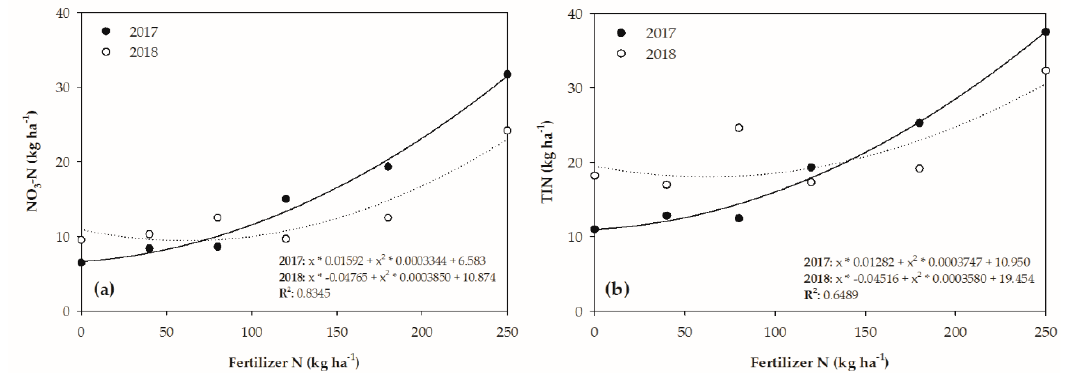
Figure 2. ( a ) response of post-harvest soil NO 3 -N and ( b ) total inorganic nitrogen (NO 3 -N + NH 4 -N, TIN) to fertilizer nitrogen (N) rate for first-year maize in 2017 and 2018.